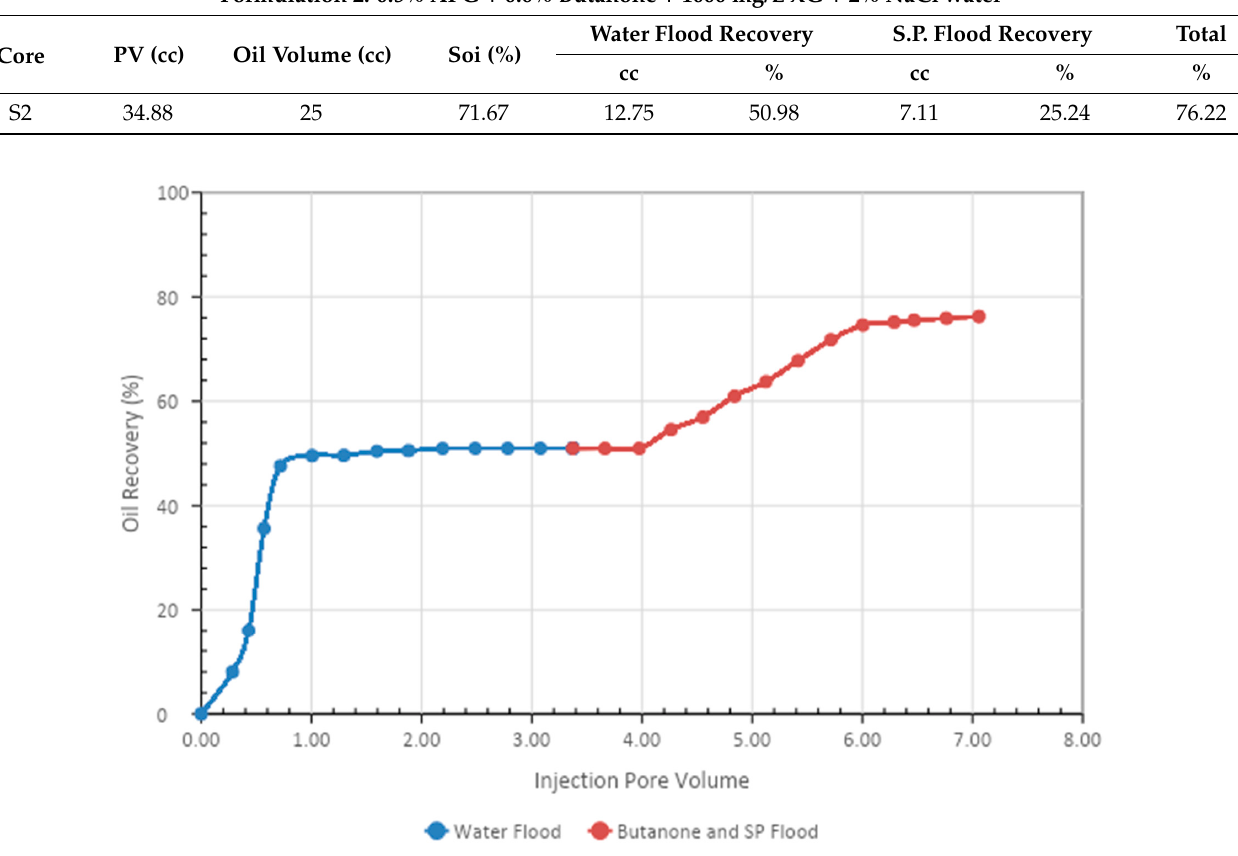
Figure 12. Total oil production from the core after brine, butanone, and SP mixture, followed by a post-flood with brine.